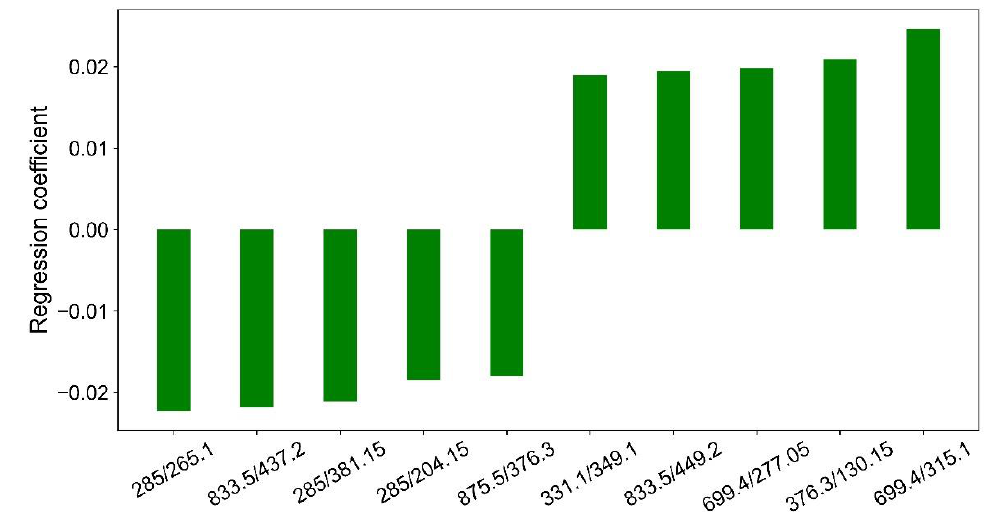
Figure 4. Regression coefficients of 10 major features by PLS decomposition.